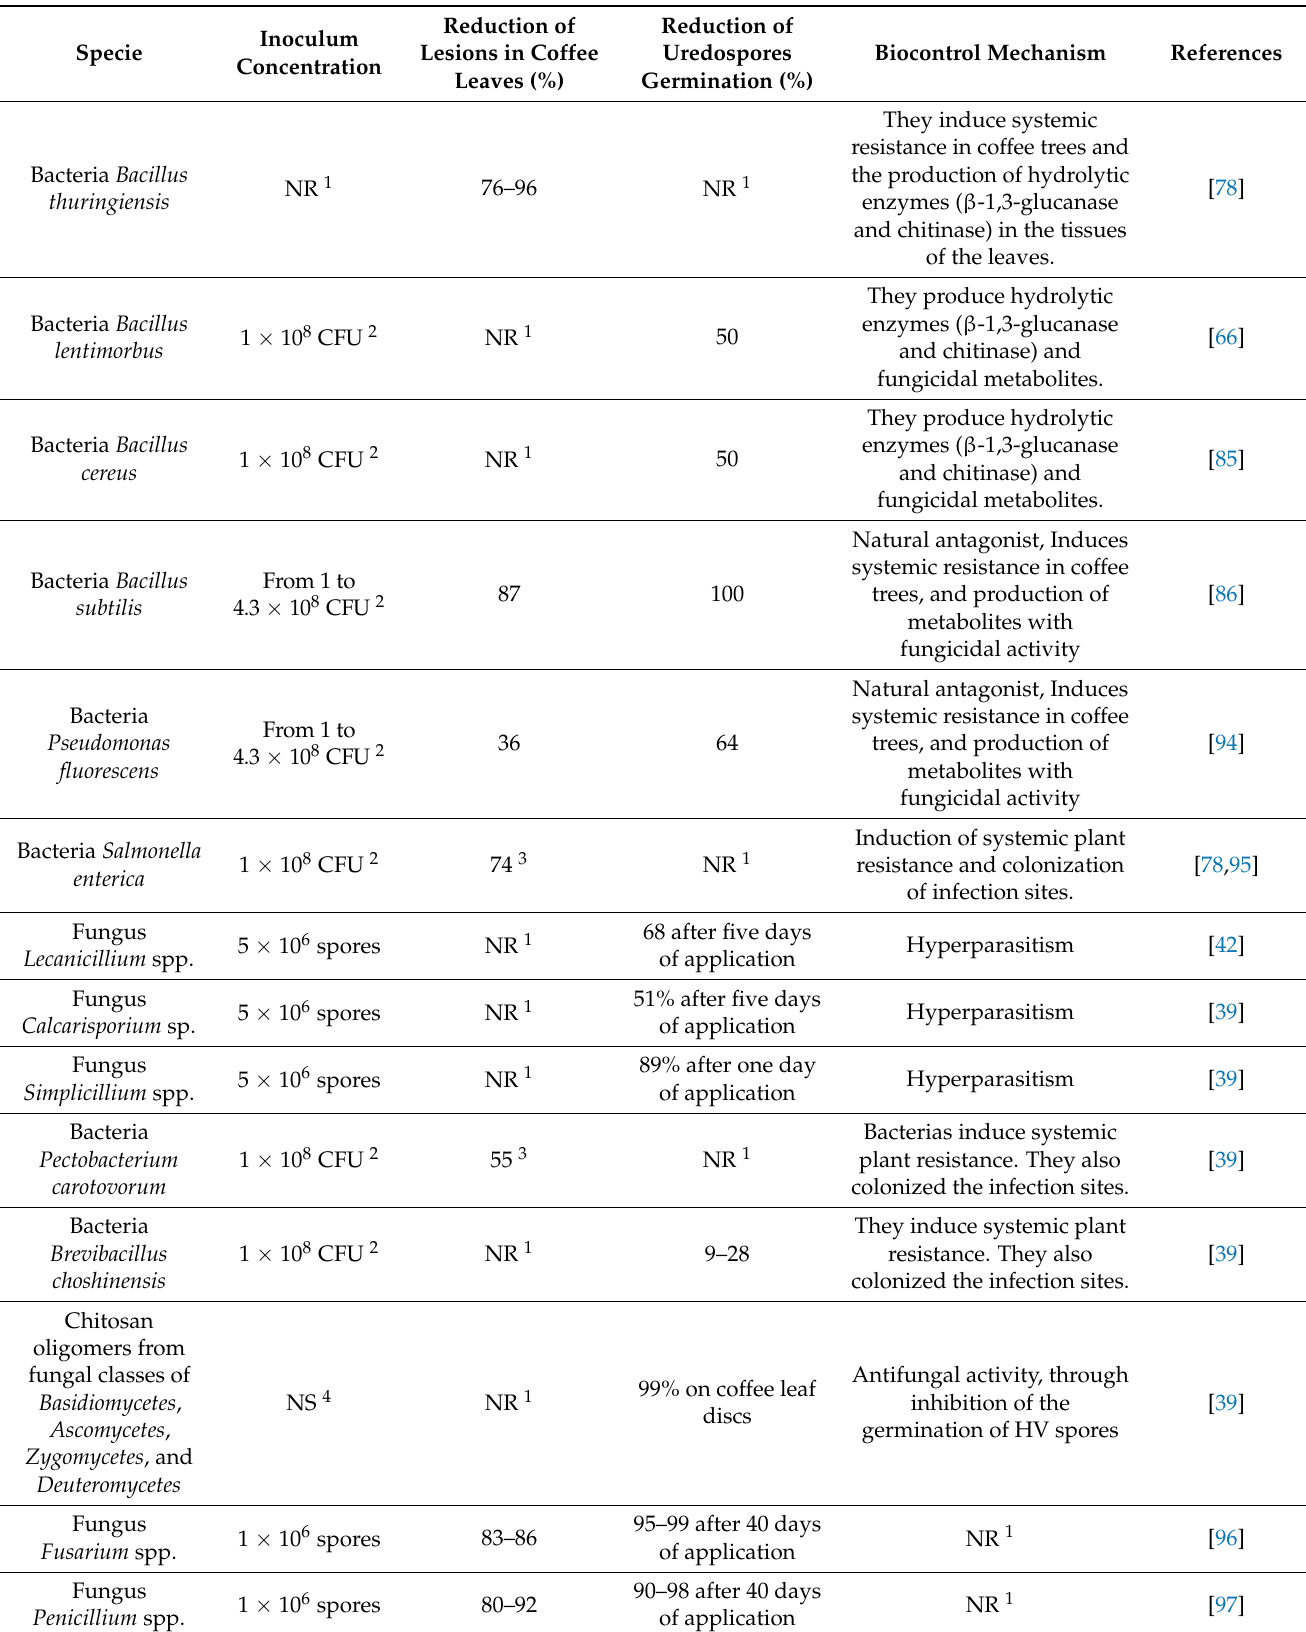
Table 4. Uses of bacteria and fungi against Hemileia vastatrix